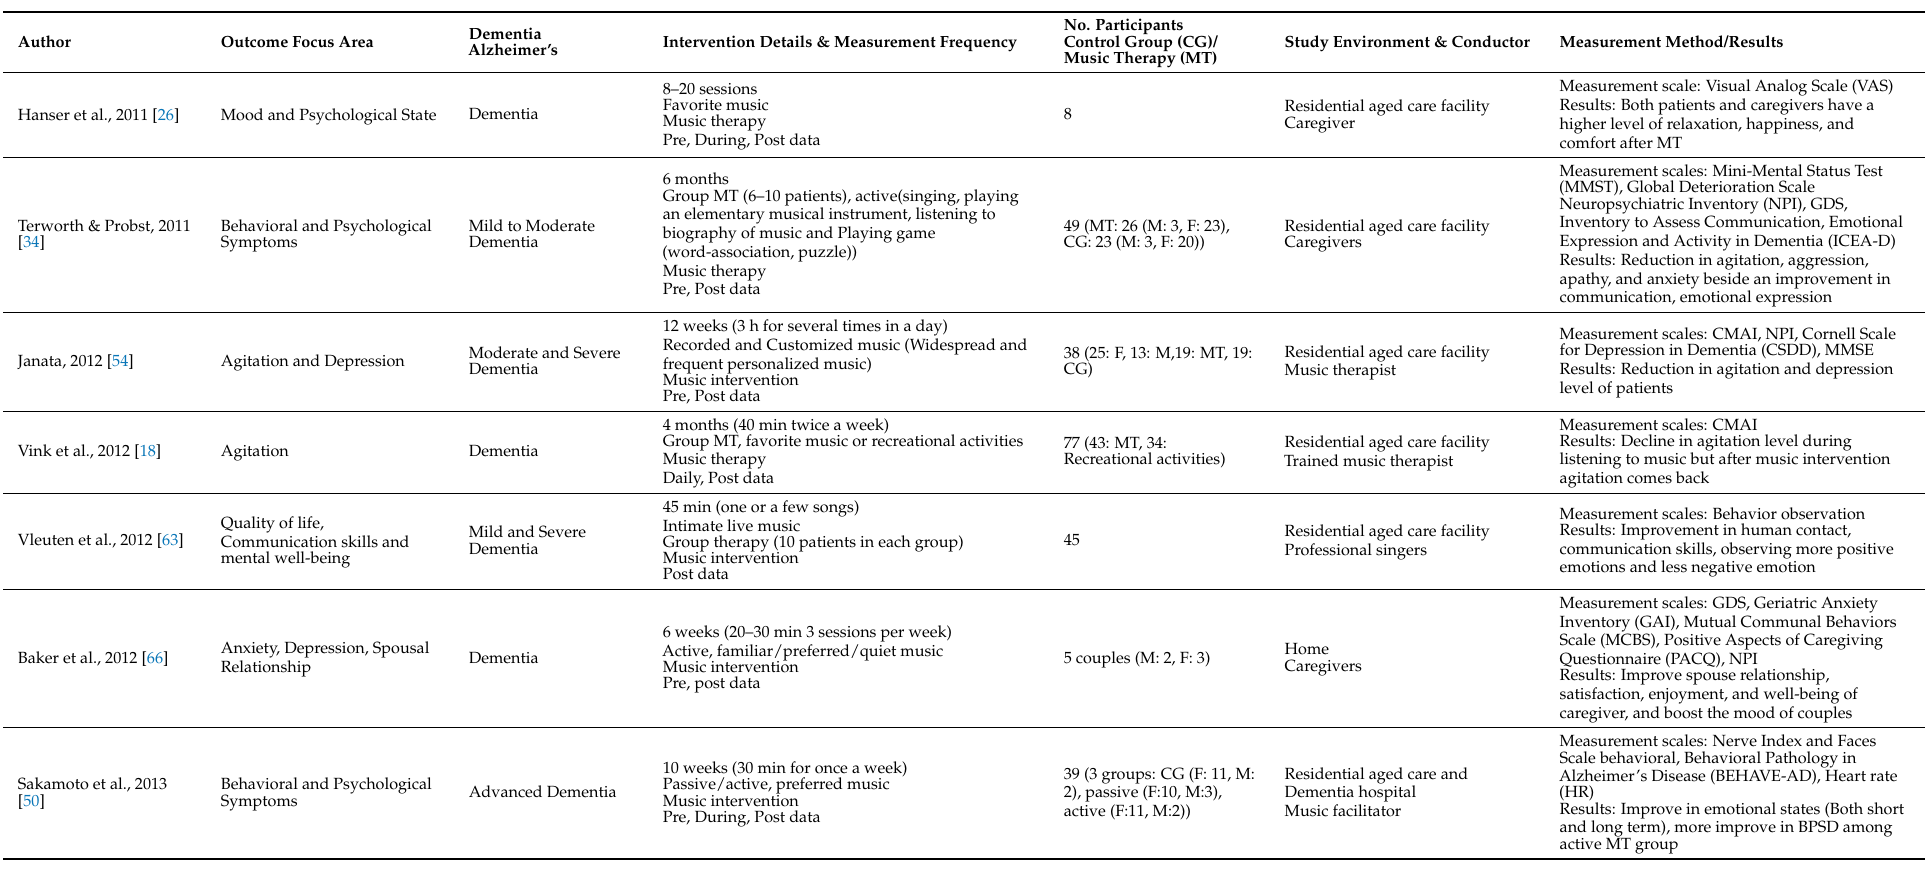
Measurement scale: Visual Analog Scale (VAS) Results: Both patients and caregivers have